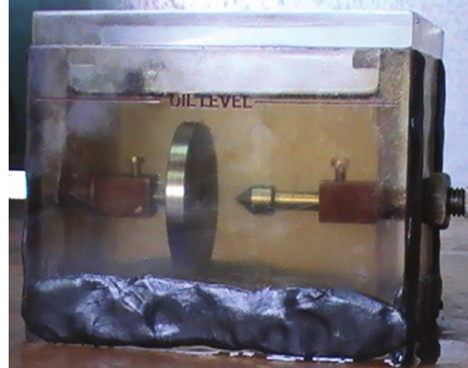
Figure 9: Laboratory model replicating electrode bounded cavity discharge.